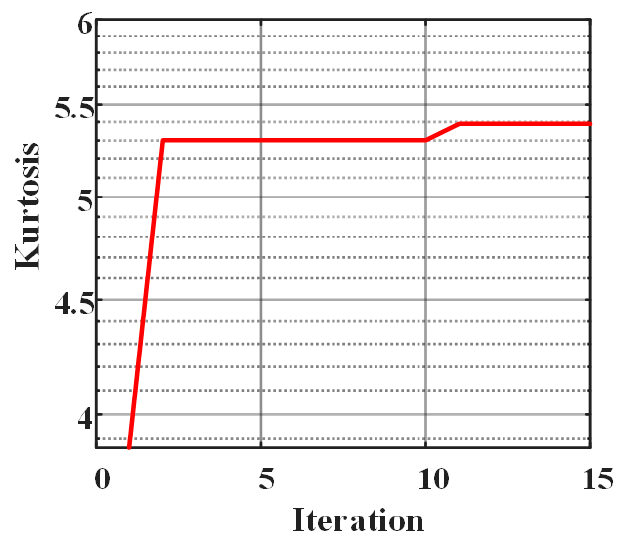
Figure 4. Optimization process of the WOA.